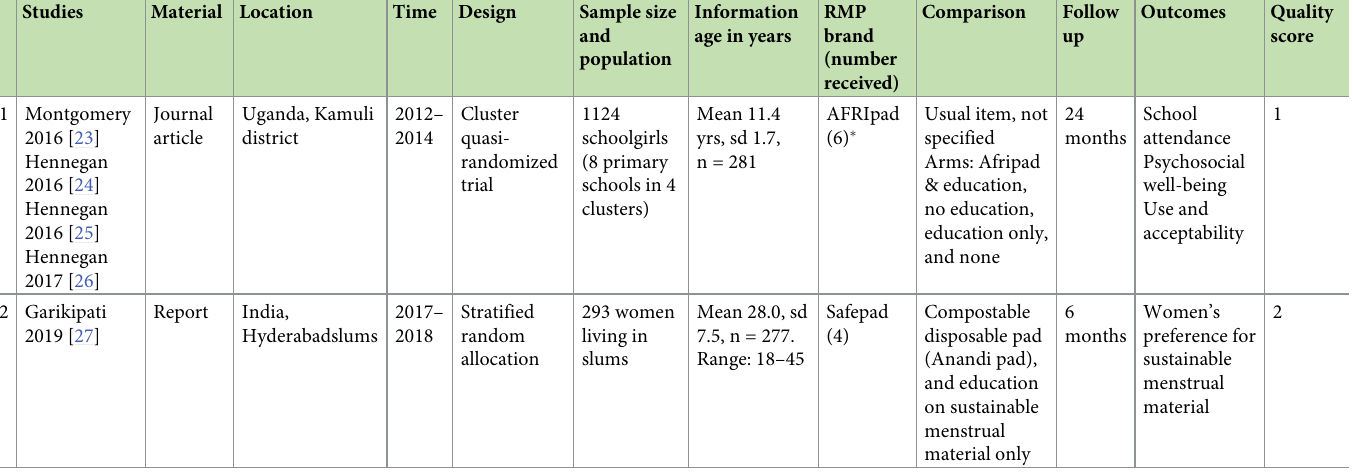
Table 1A. Characteristics of trials contributing to the Reusable Menstrual Pad review (alphabetical